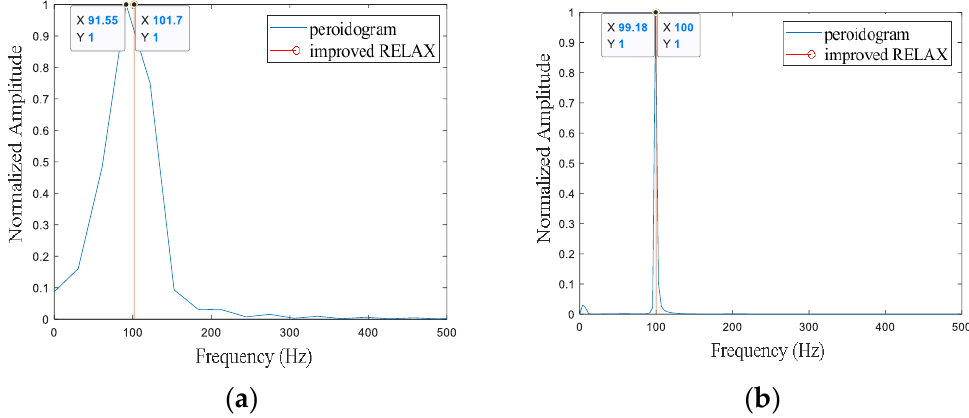
Figure 4. The influence of the sampling point cardinality at a single frequency on frequency estimation, involving a signal frequency sampling point of ( a ) 2000 and ( b ) 20,000. Table 2. Estimation error.